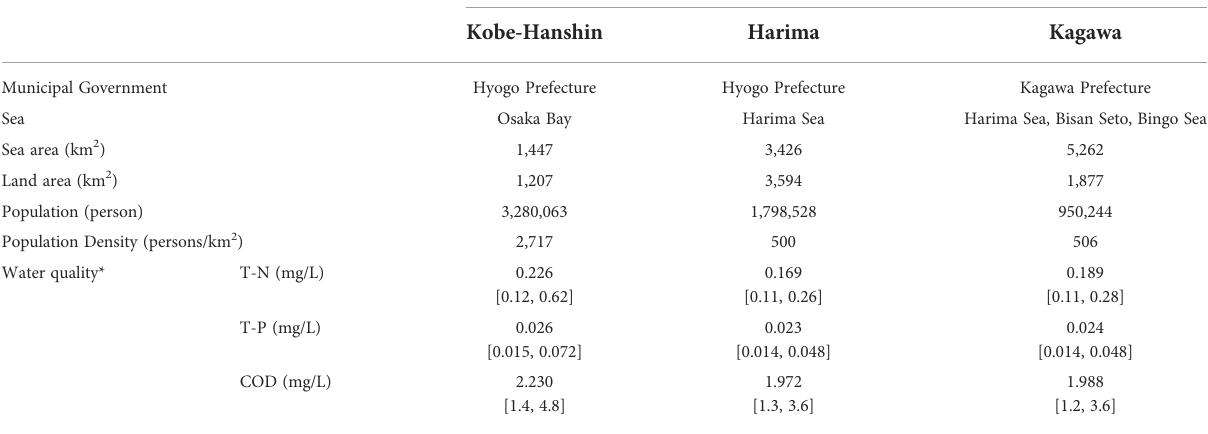
TABLE 1 The primary characteristics of the three